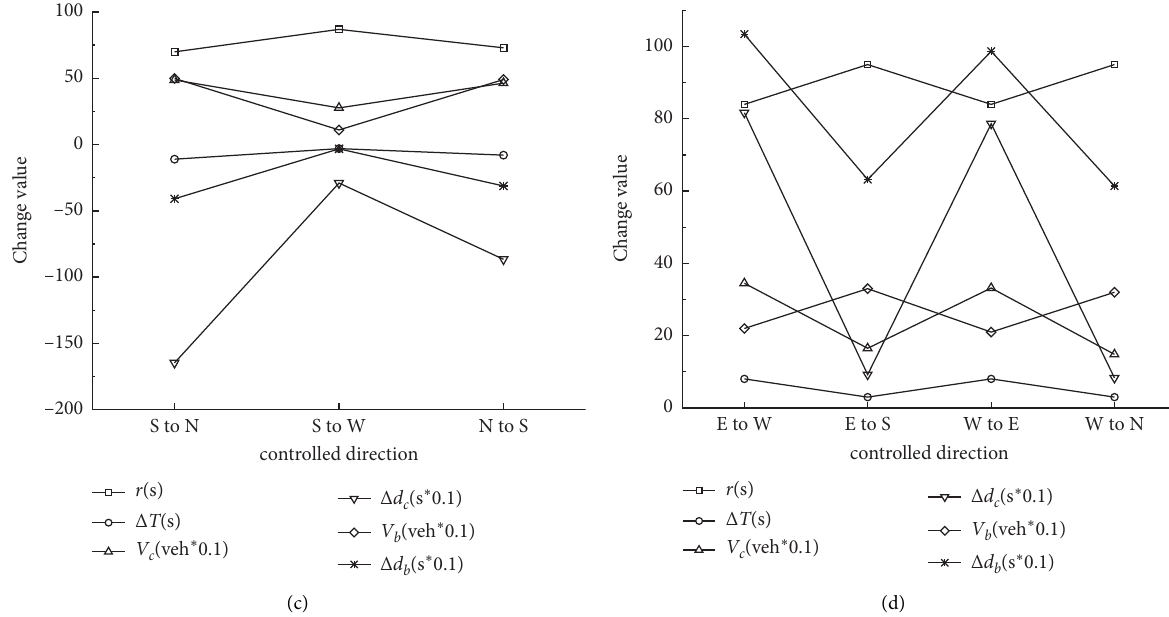
Figure 8: Analysis of the influencing factors related to the change in total passenger delay at intersections. (a) Analysis of decreased value of the passenger delay at Huizhou Avenue and Ziyun Road intersection. (b) Analysis of increased value of the passenger delay at Huizhou Avenue and Ziyun Road intersection. (c) Analysis of decreased value of the passenger delay at Huizhou Avenue and Jinxiu Avenue